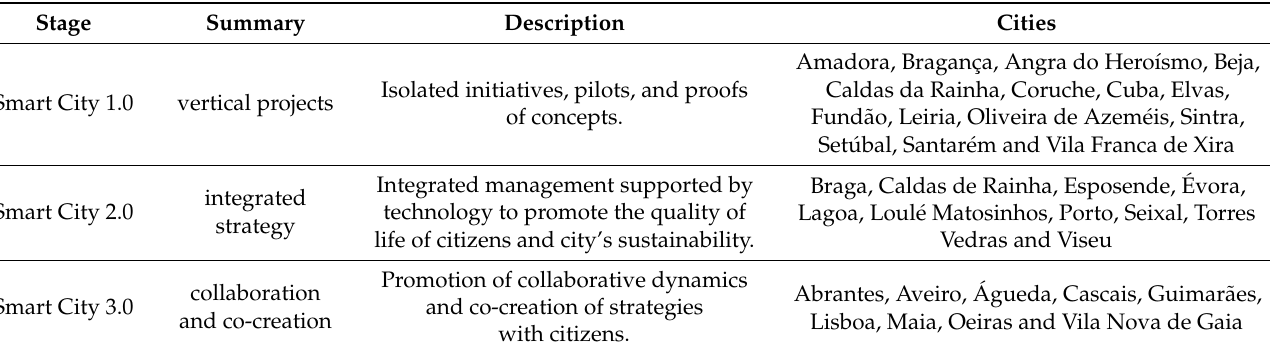
Table 5. Portuguese Cities association over the smart city concept